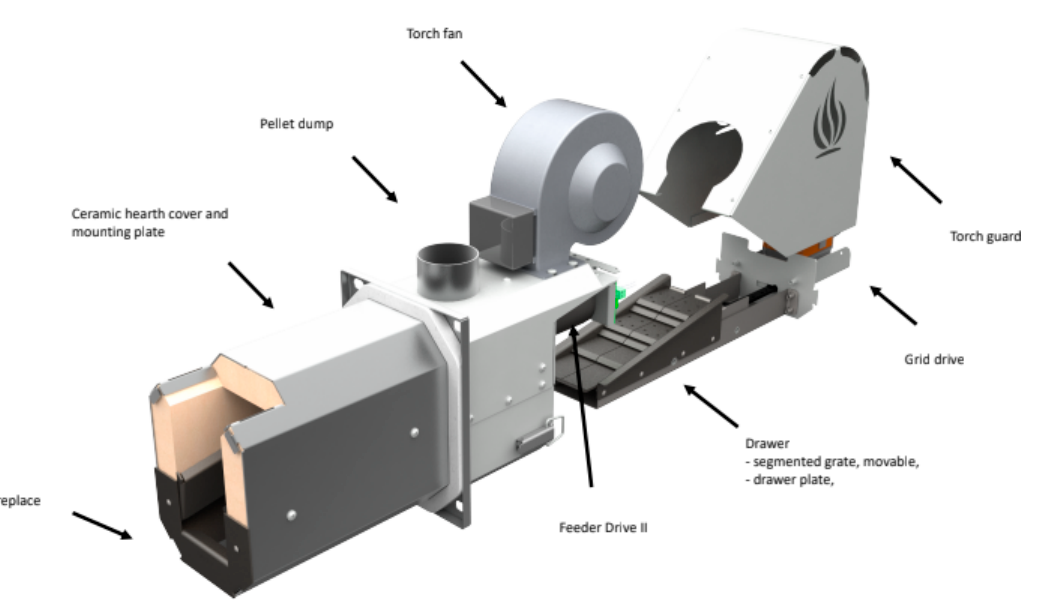
Figure 1 . Cross section of tested solid fuel boiler [28].